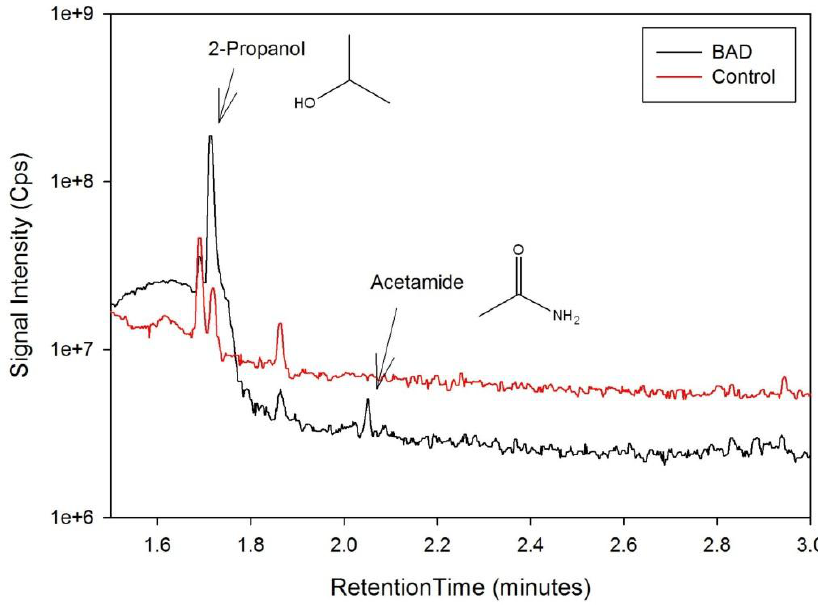
Figure 5. Section of a BAD sample GC Chromatogram showing unique peaks.